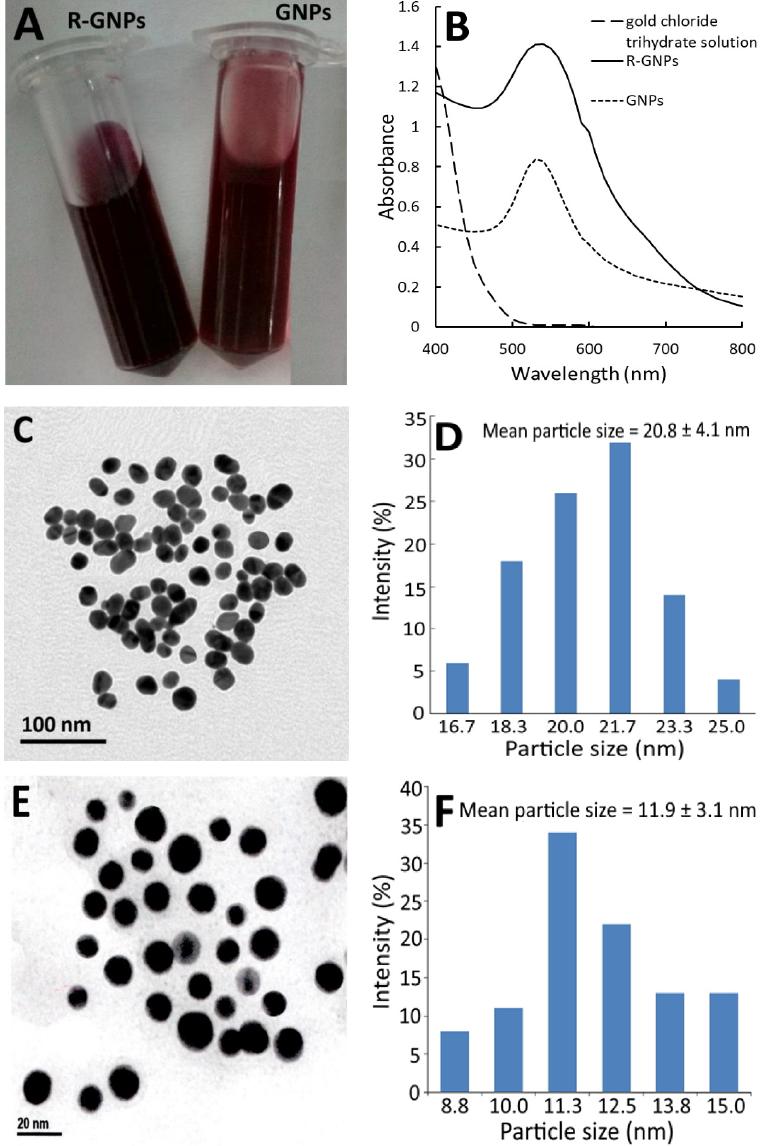
Figure 2. Appearance of gold nanoparticles (GNPs) and resveratrol-gold nanoparticles (R-GNPs) ( A ) and their absorption spectra showing the surface plasmon resonance peak, respectively, at 528 and 538 nm ( B ) as well as the transmission microscopic image obtained at 120 kV ( C , E ) along with particle size distribution ( D , F ) for GNPs ( C , D ) and R-GNPs ( E , F ).